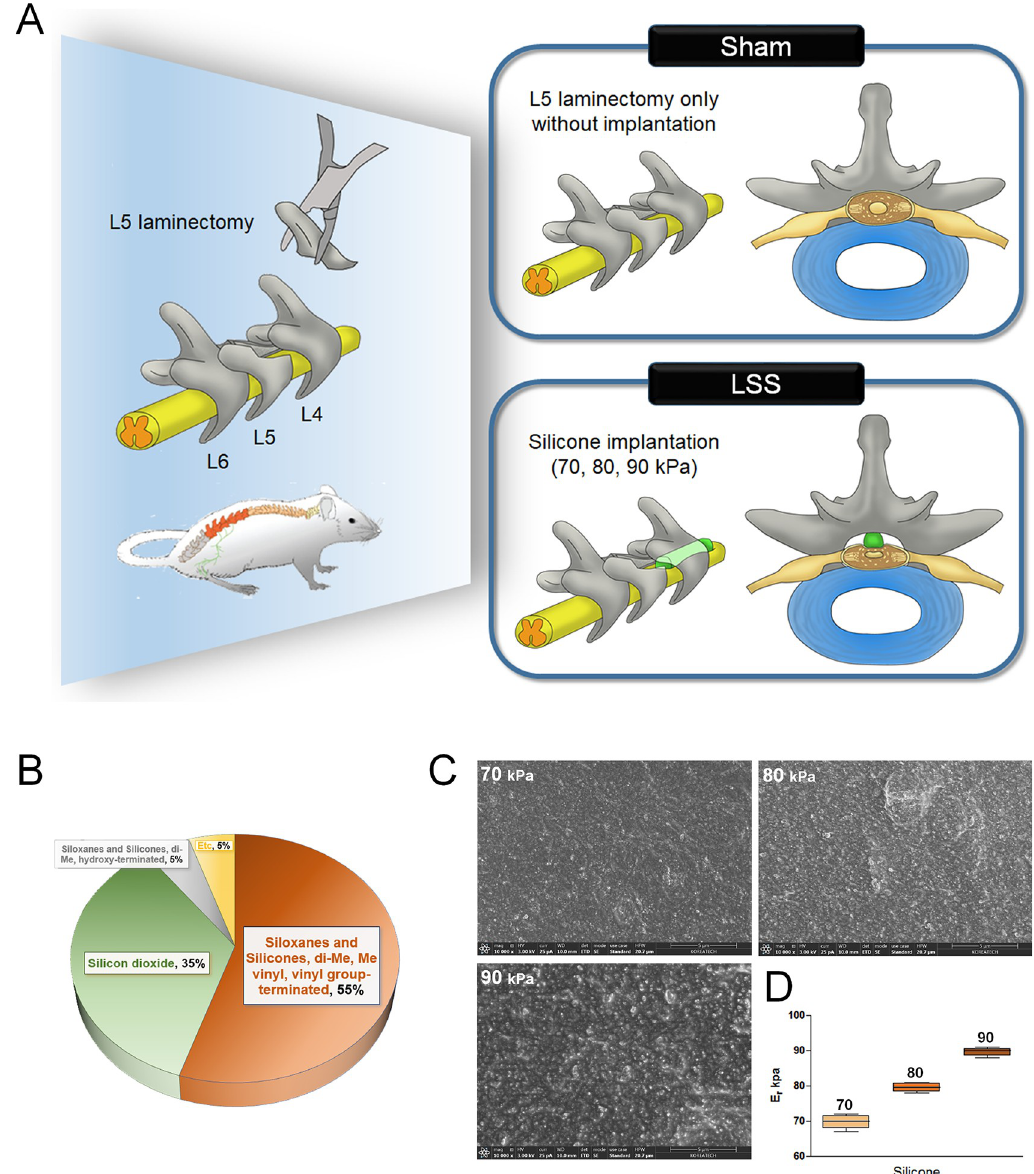
Fig 1. Characteristics of silicone blocks used for the induction of LSS. (A) Schematic of the experimental design for establishing a LSS model using silicone blocks with graded hardness. (B) Characterization of the silicone components. (C) SEM images of the surface morphology of silicone blocks with differing hardness. (D) Elastic modulus values from